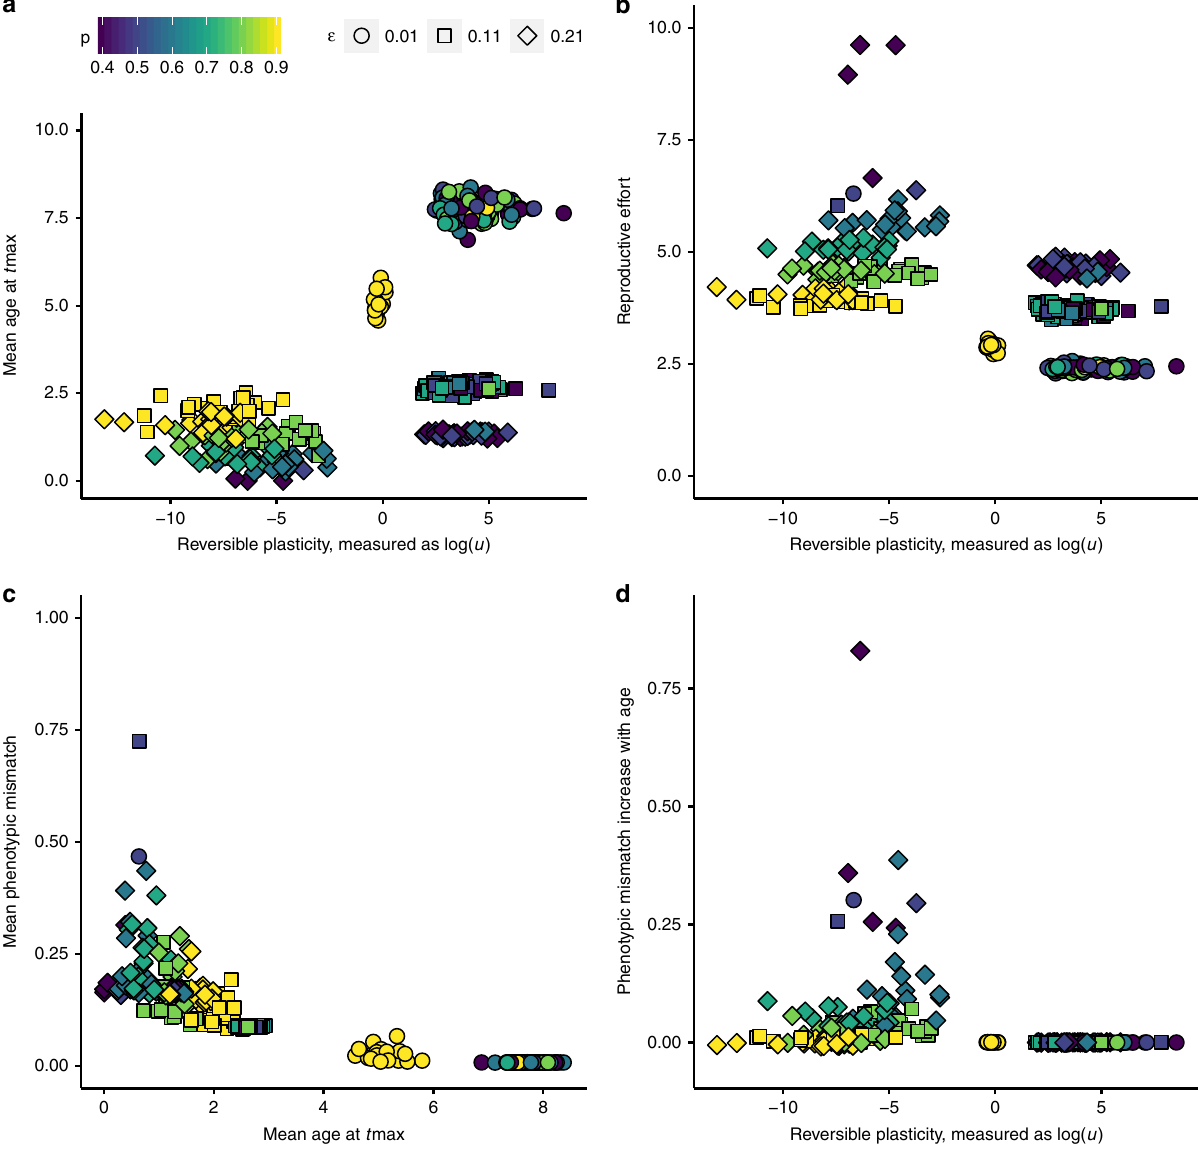
Fig. 2 Relationships between populations mean trait values at the end of all simulations. a Mean age of individuals — a measure of lifespan — measured at the end of the simulation ( t max ); long lifespan is only found at high plasticity levels. b Mean evolved reproductive effort (gene value) covaries negatively with plasticity, measured as updating effort, u . c Mean population-wide mismatch against mean age of individuals measured at t max . d The regression slope between individual mismatch and individual age, measured at t max , with positive values indicating that older individuals are more mismatched to the current environment. Frequent enough plasticity can prevent this type of senescence. Symbol shapes indicate sampling error ( ɛ ); colour (from dark blue to yellow) indicates increasing environmental autocorrelation ( p